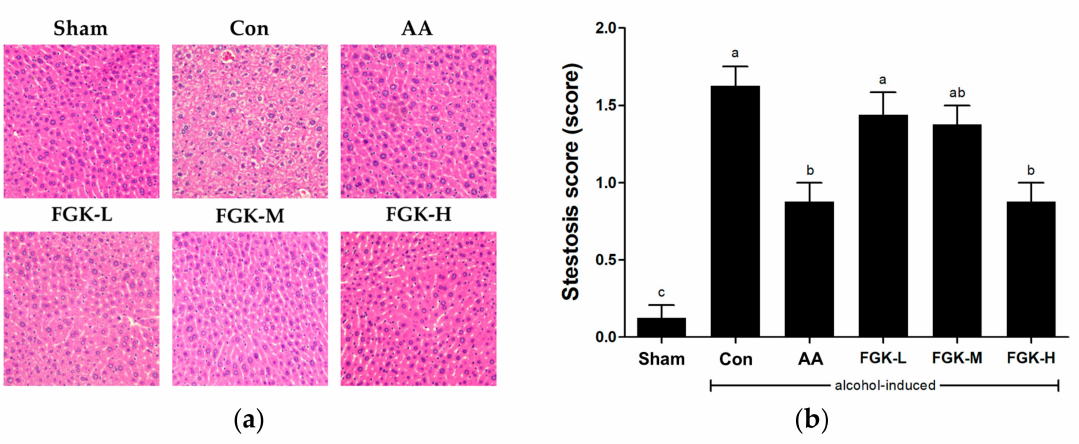
Figure 2. Effects of fermented gold kiwi (FGK) on the livers of alcohol-induced mice. ( a ) Histopatho- logical changes; ( b ) steatosis score. Sham, mice treated with only saline; Con, mice treated with alcohol and saline; AA, mice treated with alcohol and ascorbic acid (25 mg/kg); FGK-L, -M, -H, mice treated with alcohol and FGK at 50, 126, and 250 mg/kg, respectively. Results expression as means ± SEM ( n = 8). a–c Different letters indicate significant differences ( p < 0.05) among the groups, as determined by Tukey’s analysis.